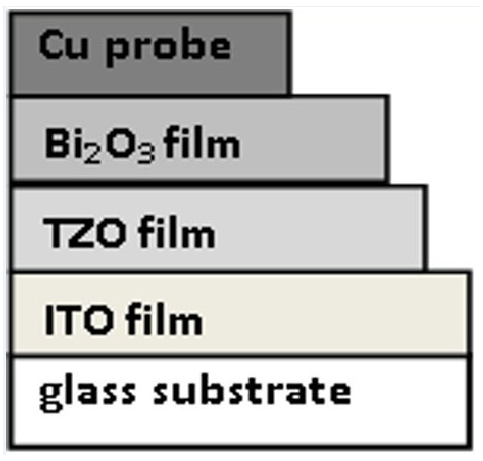
Figure 1. Schematics of TZO/Bi 2 O 3 film. Table 1. Sputtering process parameters of TZO/Bi 2 O 3 film.